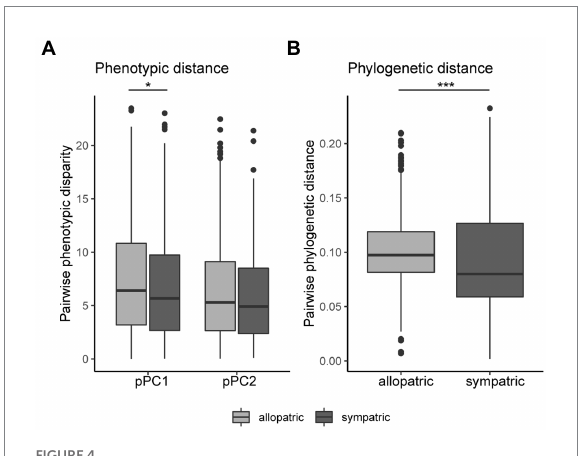
FIGURE 4 Phenotypic and phylogenetic distance between sympatric and allopatric species pairs. (A) Species with entirely allopatric range distributions show greater phenotypic disparity in floral pPC1 (representing size), but not floral pPC2 (width/inflorescence), compared to species pairs that share some or geographic range (sympatry; pPC1: Kruskal–Wallis X 2 = 4.95, df = 1, * p = 0.026; pPC2: Kruskal–Wallis X 2 = 1.21, df = 1, p = 0.27). (B) Phylogenetic distance is greater between species pairs in allopatry than in sympatry (Kruskal − Wallis X 2 = 18.369, df = 1, *** p <